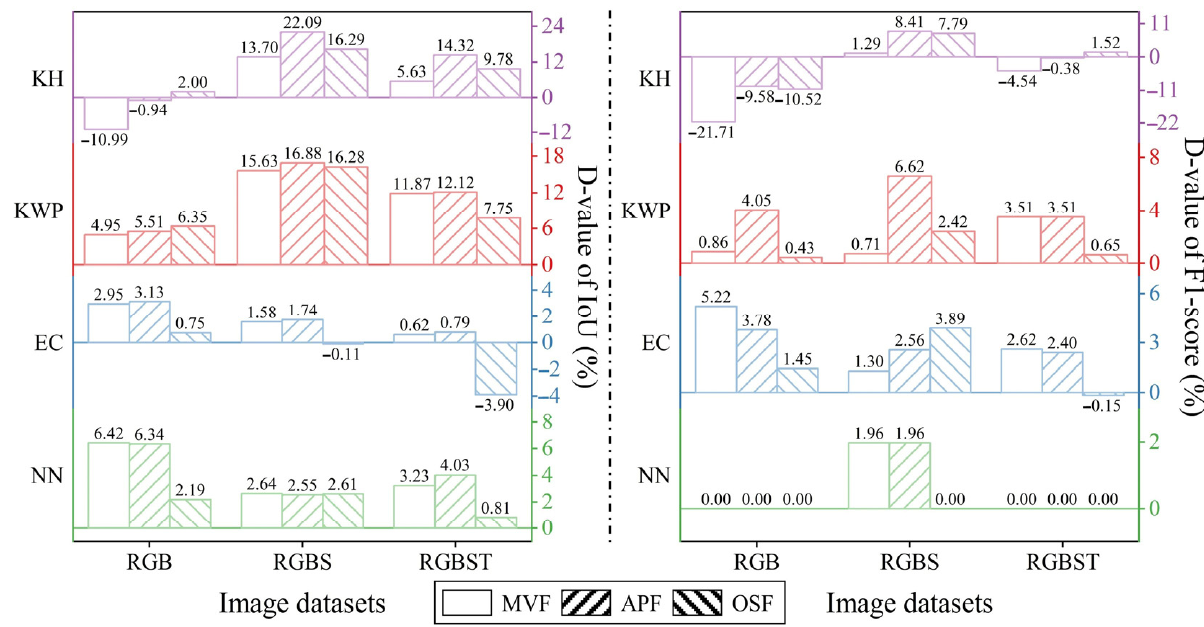
Figure 16. The accuracy differences between OC-FCMs and MC-FCMs with different image datasets for karst wetland vegetation.